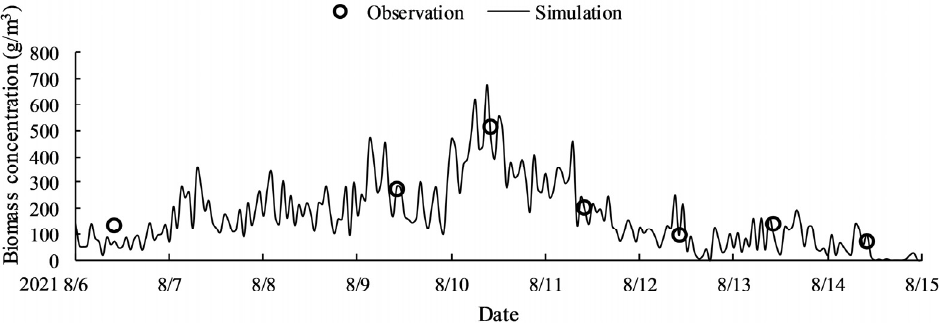
Figure 5. Comparison between the observed and simulated biomass concentration of green macroal- gae for the particle-tracking model in the Jinmeng Bay domain.